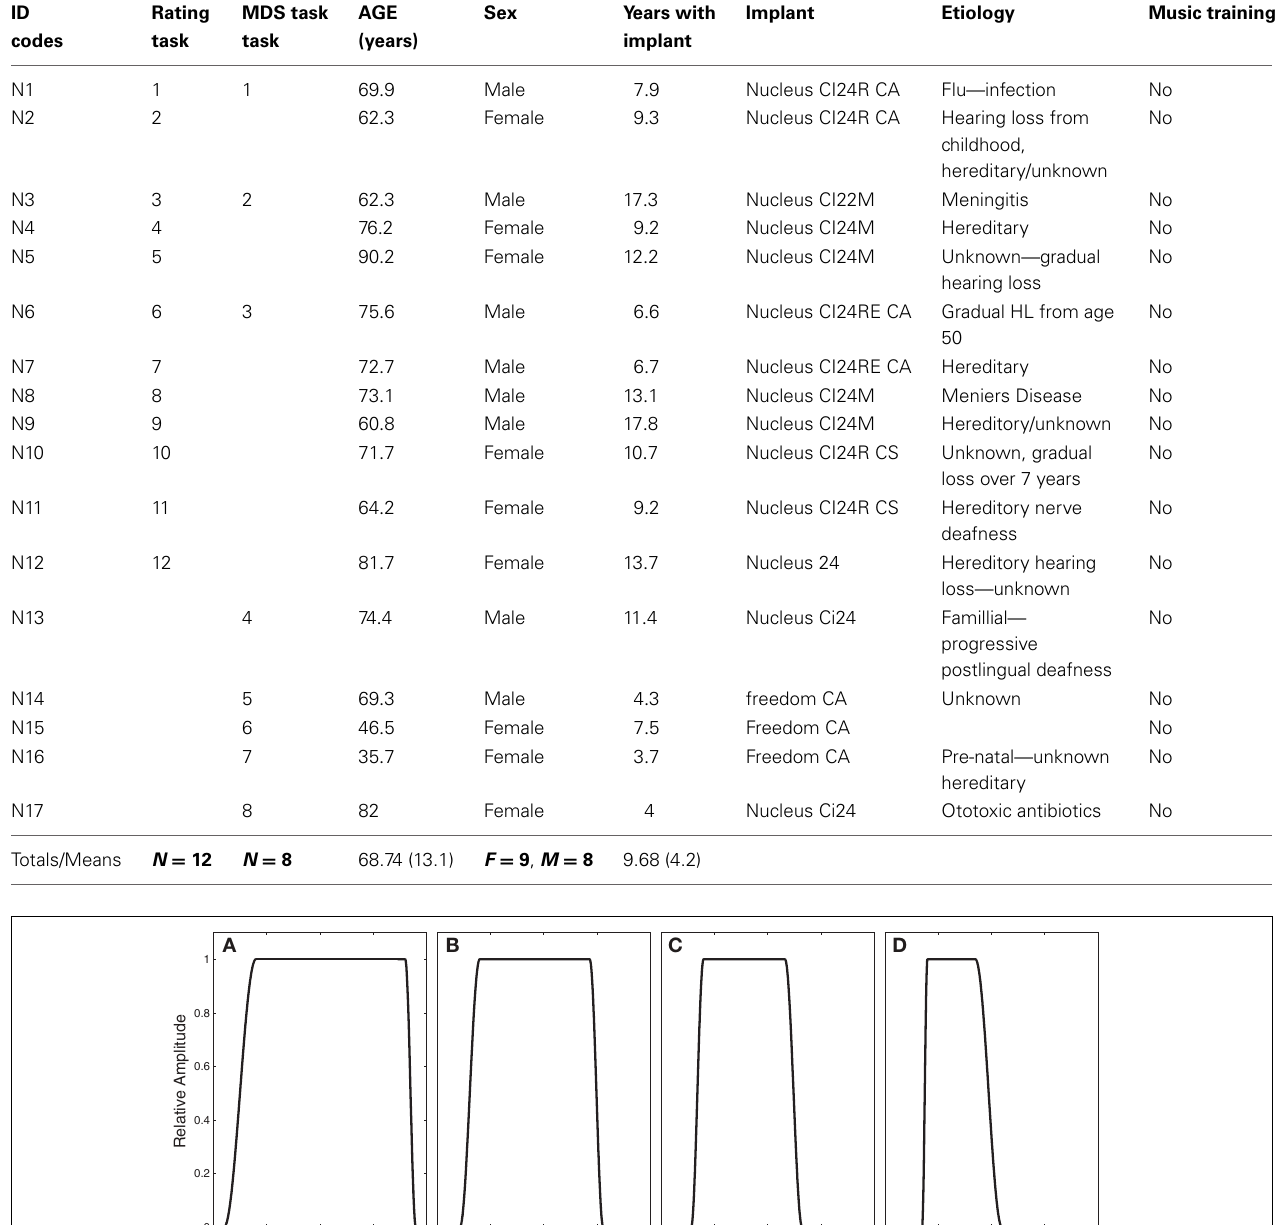
Table 1 | Summary of participant information.